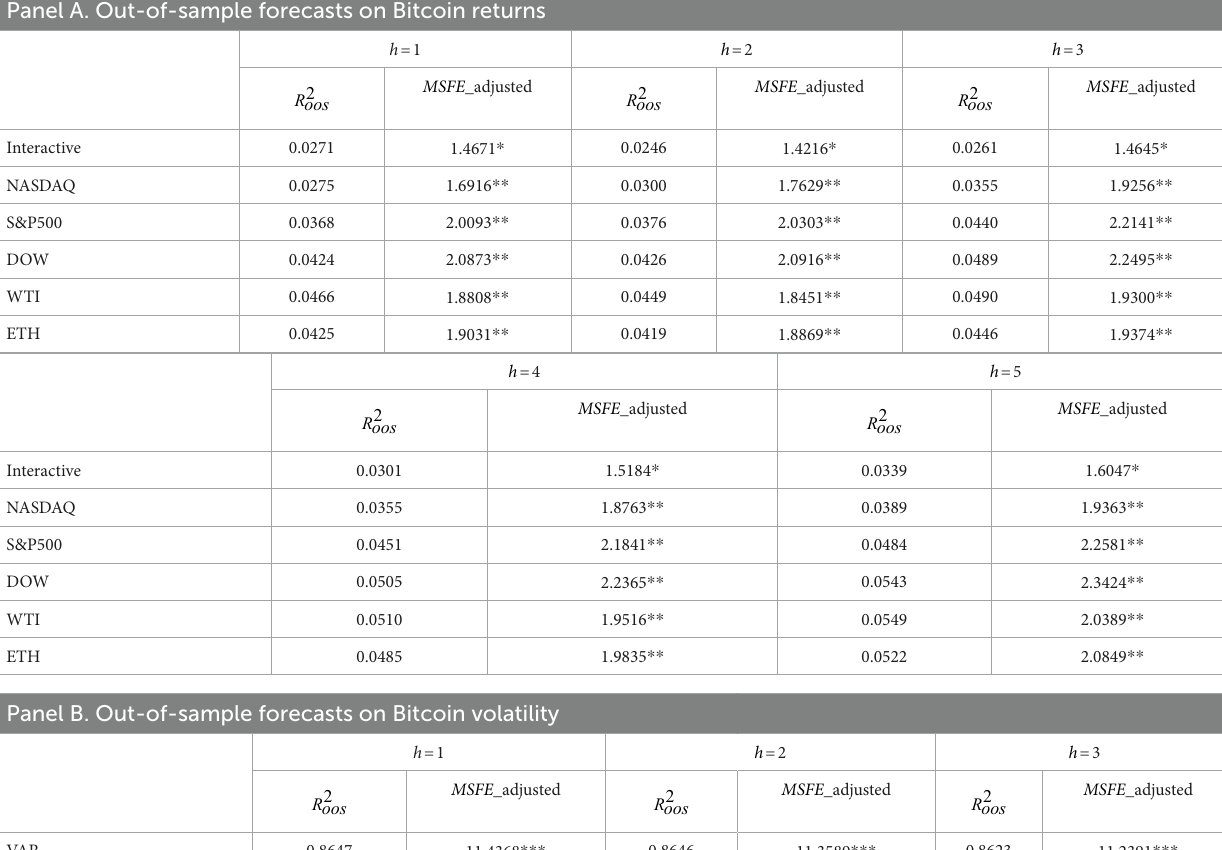
TABLE 8 Out-of-sample forecasts results for the returns and volatility of Bitcoin futures. Panel A. Out-of-sample forecasts on Bitcoin